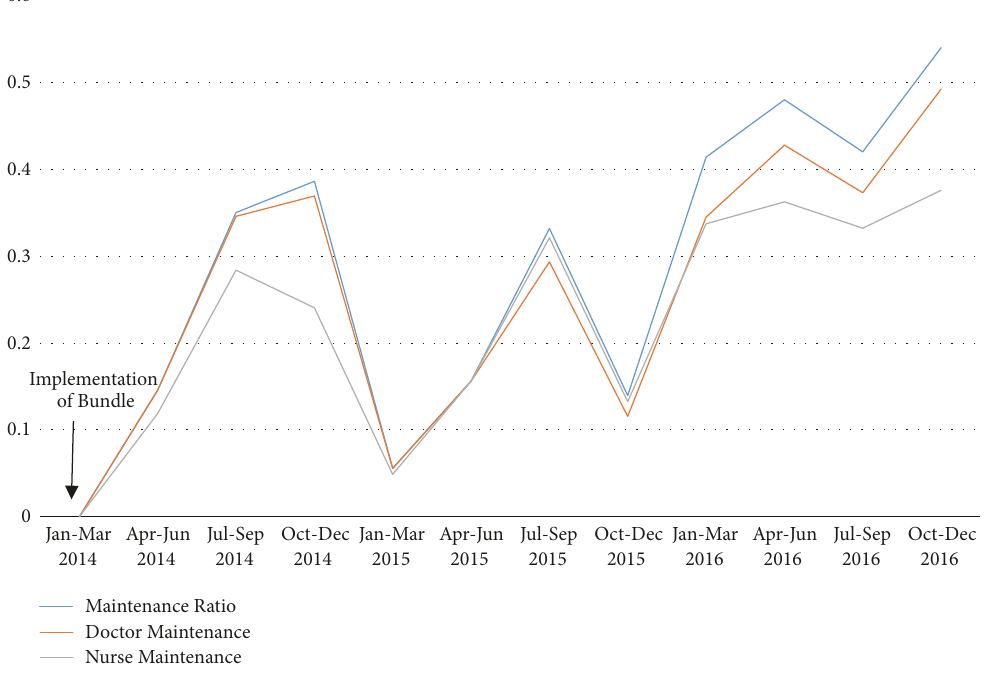
Figure 5: Maintenance ratio during implementation period of a central line bundle. Maintenance represented as a ratio of maintenance days/amount of days in which central lines were in place. Table 2: Central Line Associated Bloodstream Infections (CLABSI) per 1,000 central line days for different weight categories. Birthweight Category